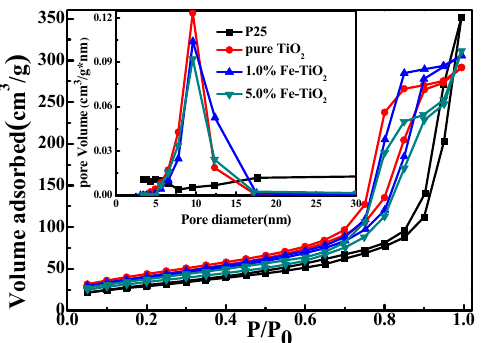
Figure 9. N 2 adsorption–desorption isotherms and the pore size distributions of photocatalysts. Table 2. Surface area, total pore volume and average pore diameter of photocatalysts.